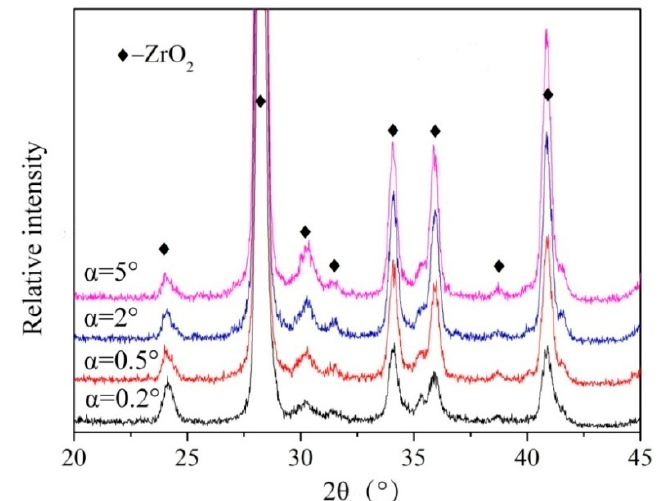
Figure 5. XRD patterns of the annealed ZrO 2 thin film.